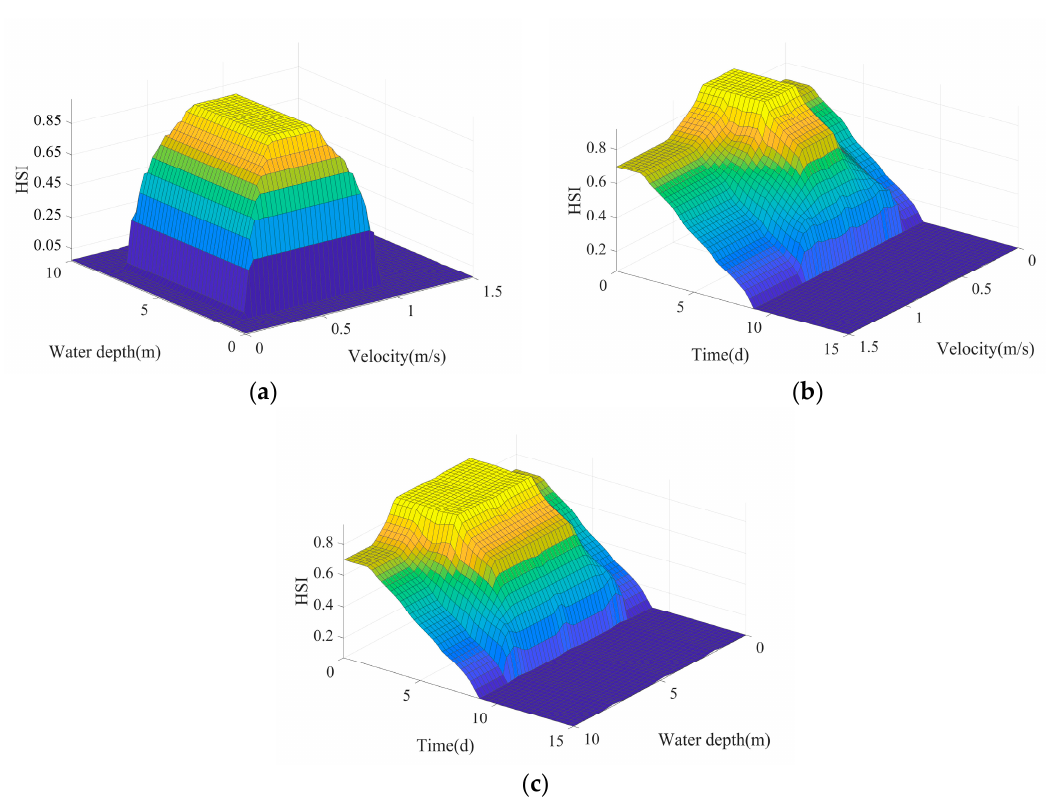
Figure 10. Output for habitat suitability index (HSI) after defuzzification. ( a ) HSI of velocity and water depth, ( b ) HSI of velocity and water temperature lag time, and ( c ) HSI of water depth and water temperature lag time.